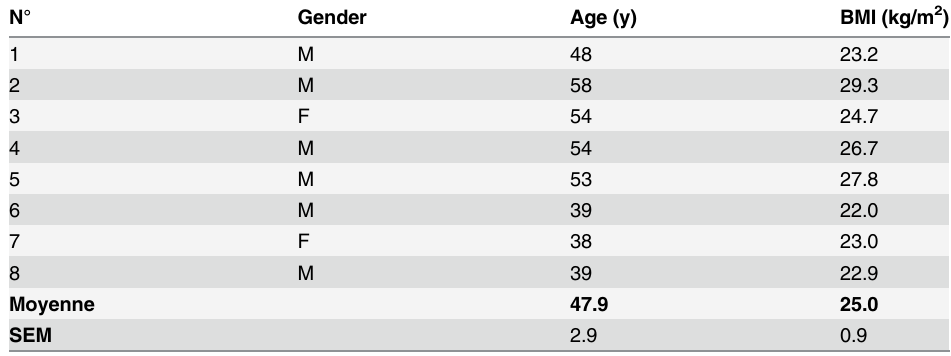
Table 1. Characteristics of human islet